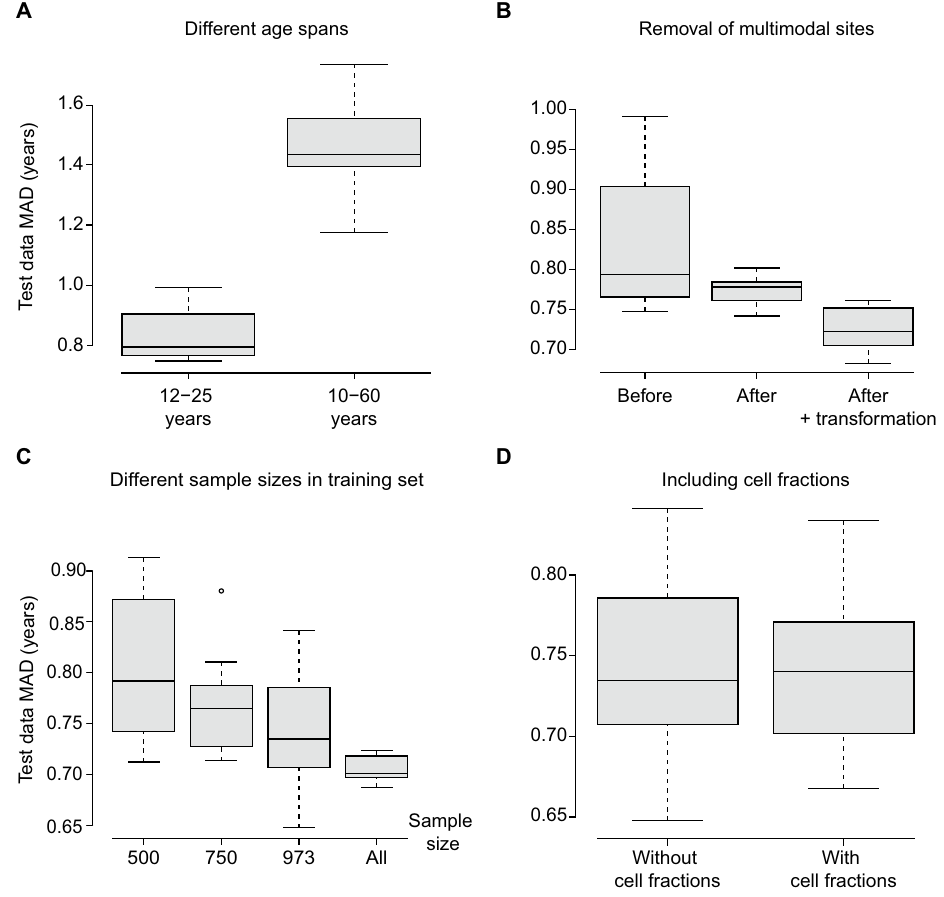
Figure 2. Impact of different methodological factors on the performance of the model. ( A ) Impact of using different age spans. ( B ) Removal of multimodal sites. ( C ) Impact of different sample sizes. ( D ) Including cell fractions in the